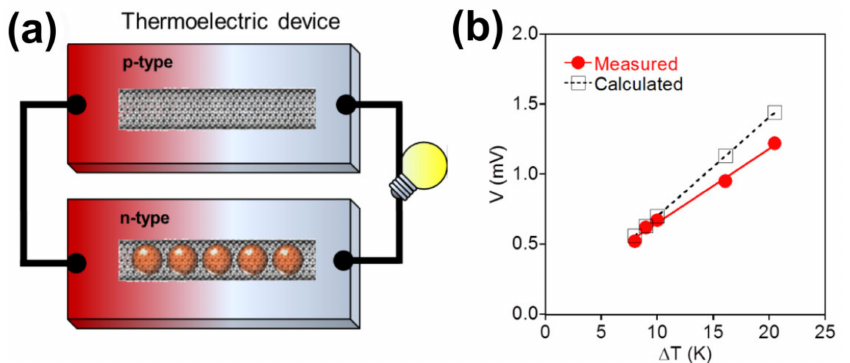
Figure 8. ( a ) Layout of a thermoelectric device build from empty SWCNTs and CoCp 2 -encapsulated SWCNTs. ( b ) Measured (red circle) and calculated (black square) voltage output of the thermoelectric device versus the applied temperature gradient. Reproduced from [200]. Published by SpringerNature under a Creative Commons Attribution-Non-commercial-NoDerivs 4.0 International